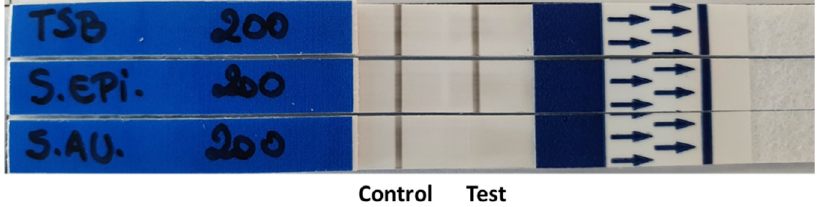
Figure 4. LF strip optimization. Versatility of the LF-TT probe for other commercially available strips containing a similar system.